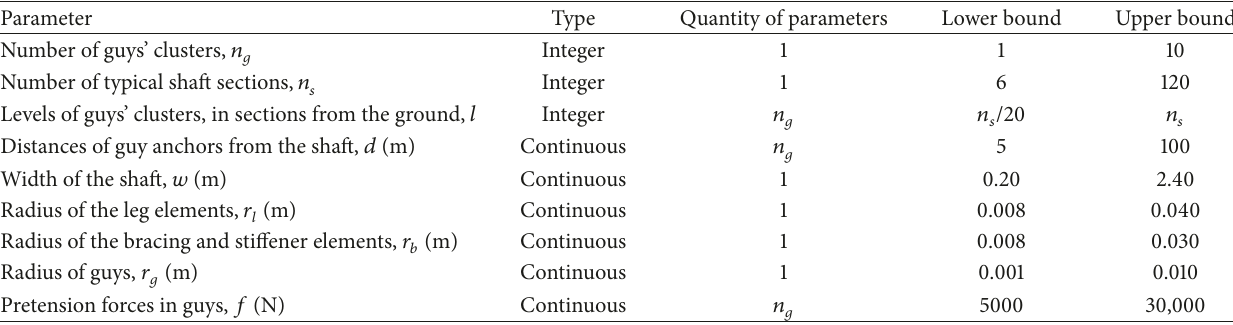
Table 1: Set of design